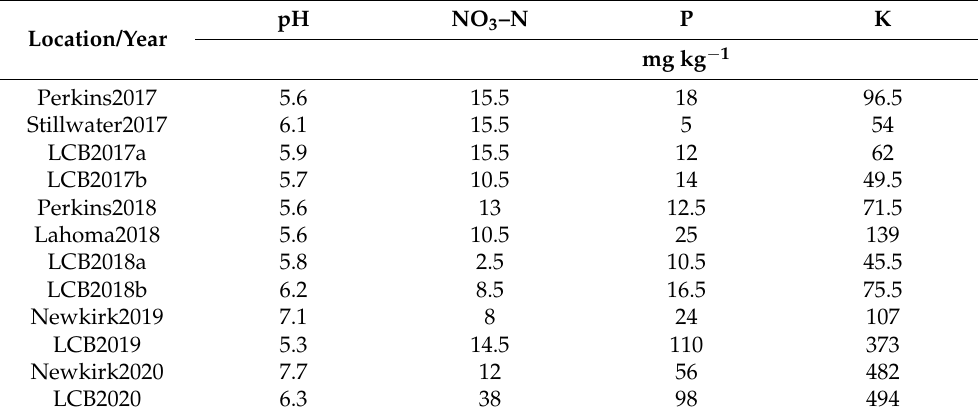
Table 2. Soil pH and nutrient contents of all experimental